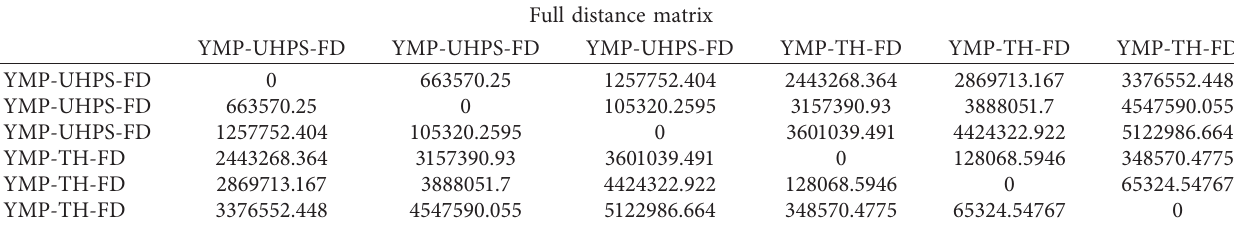
Table 2: Euclidean distances of YMP-UHPS-FD and